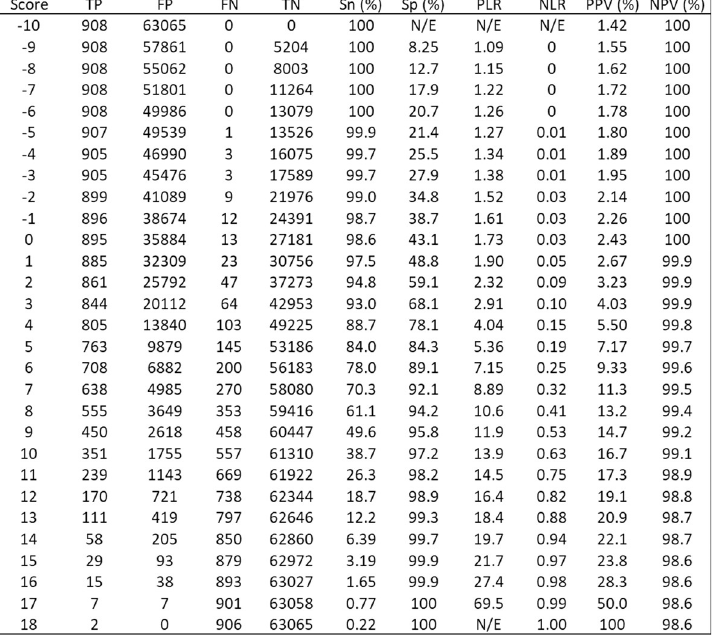
Fig 4. Full breakdown of Tm model performance. FN, xxxx; FP, xxxx; N/E, xxxx; NLR, negative likelihood ratio; NPV, negative predictive value; PLR, positive likelihood ratio; PPV, positive predictive value; Sn, xxxx; Sp, xxxx; Tm, tests-only model; TN, xxxx; TP,